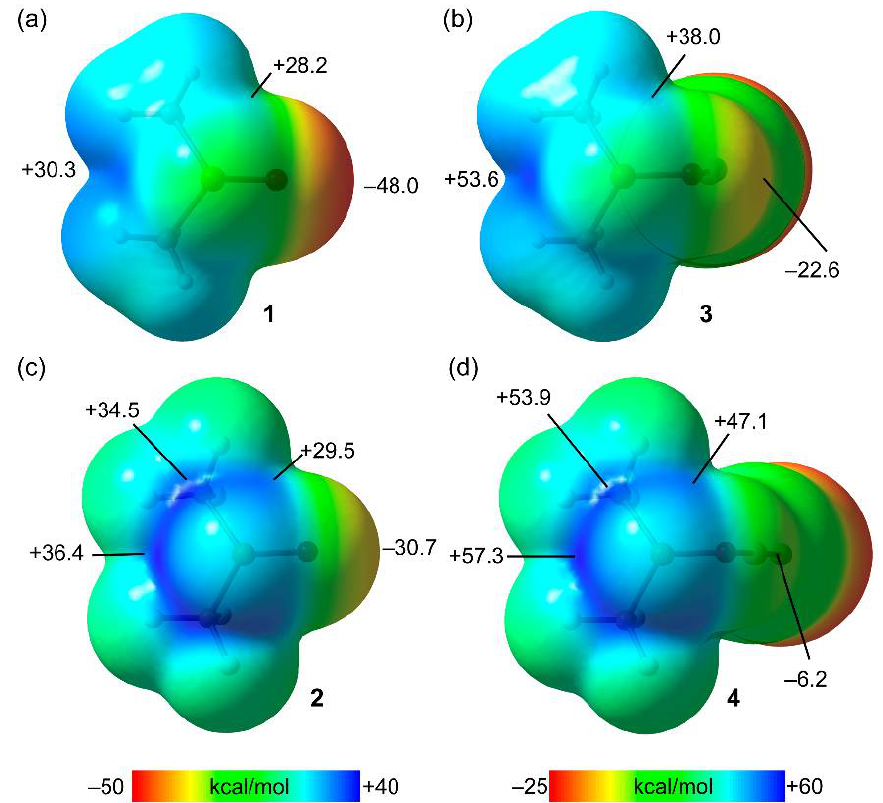
Figure 5. MEP surfaces of compounds 1 ( a ), 3 ( b ), 2 ( c ), and 4 ( d ). The energies at selected points of the surfaces are given in kcal/mol. An additional effect of the metal coordination is that the MEP value at the O atom becomes less negative ( − 22.6 kcal/mol), thus decreasing its nucleophilicity and ability to act as an electron donor. The MEP of compound 2 (see Figure 5c) shows different types of σ -holes (a total of five σ -holes), three opposite to the covalent bonds of the Se atom and two additional at the C atoms opposite to the C–F bonds. The deepest one is opposite to the Se=O bond (+36.4 kcal/mol), followed by those opposite to the C–F bonds (+34.5 kcal/mol), and finally those opposite to the Se–C bonds (+29.5 kcal/mol). The MEP at the O atom is − 30.7 kcal/mol, less negative than that in compound 1 , as expected by the introduction of the fluorine atoms. The comparison of the MEP surfaces of compounds 1 and 2 discloses that the electrophilicity of the Se atom increases moderately (MEP value increases from 30.3 kcal/mol in 1 to 36.4 kcal/mol in 2 ) whilst the nucleophilicity of the O atoms decreases significantly (MEP value changes from − 48.0 kcal/mol in 1 to − 30.7 kcal/mol in 2 ). Therefore, the fluorination increases the ability to establish ChBs but globally decreases the ability to form homodimers (Se=O ··· Se=O) due to the larger reduction of the nucleophilicity of O than the increment of electrophilicity of Se. This agrees well with the geometric features of the X-ray structures of LAWBIV and MIHFAK where the Se=O ··· Se=O distance is shorter in the non-fluorinated structure. The MEP surface of compound 4 (Figure 5d) evidences that the electrophilicity of the σ -holes increases significantly upon coordination with respect to compound 2 . Moreover, the MEP at the O atom becomes very small ( − 6.2 kcal/mol) due to the double effect of the fluorination and the coordination to the Ag